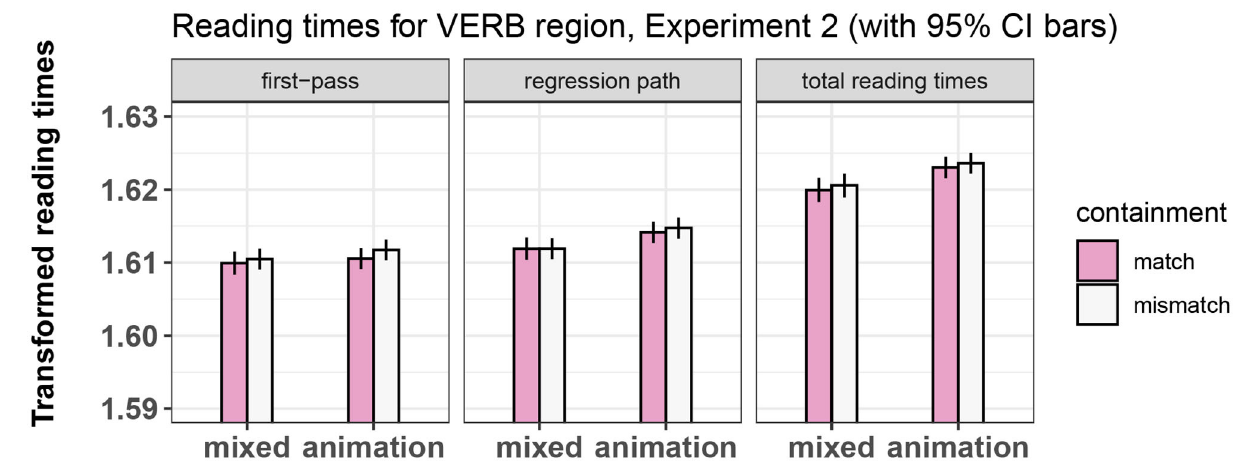
FIGURE 9 | Summary of results for the VERB region, Experiment 2.